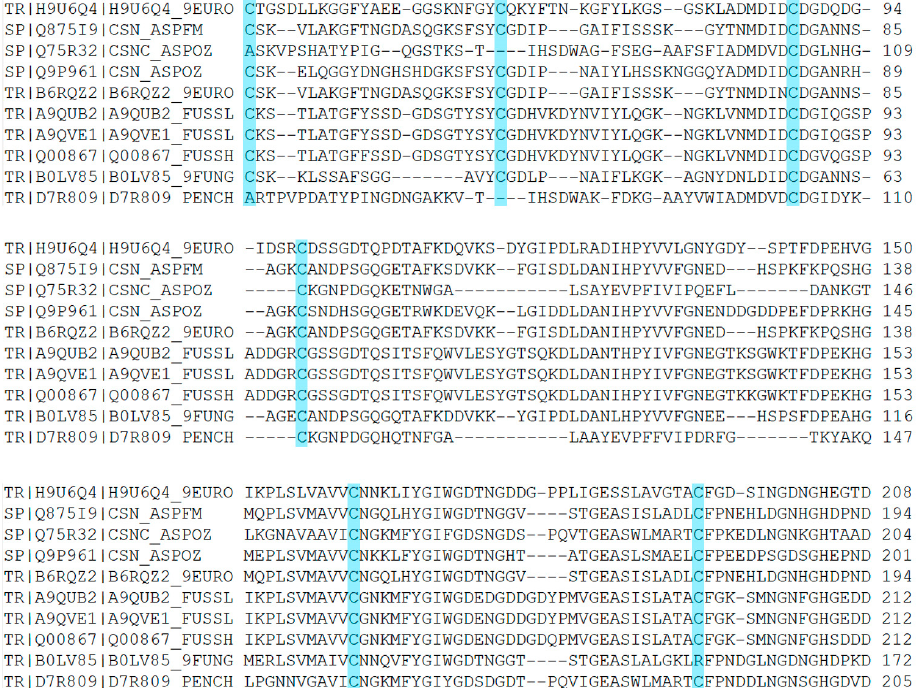
Figure A5. Sequence alignment and cysteine conservation in the family GH75.